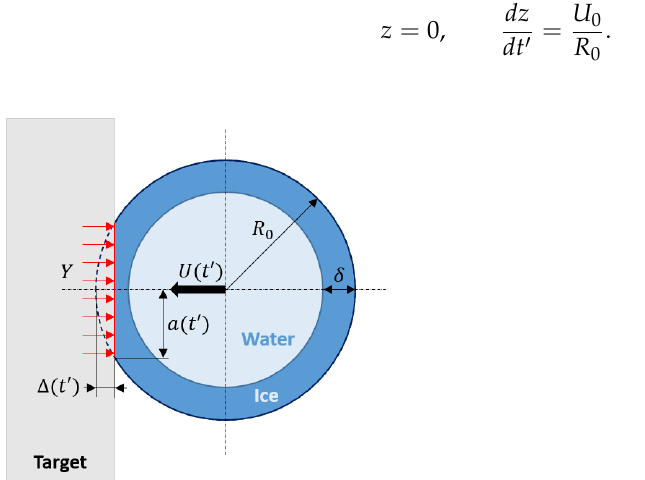
Figure 4. Particle–wall collision